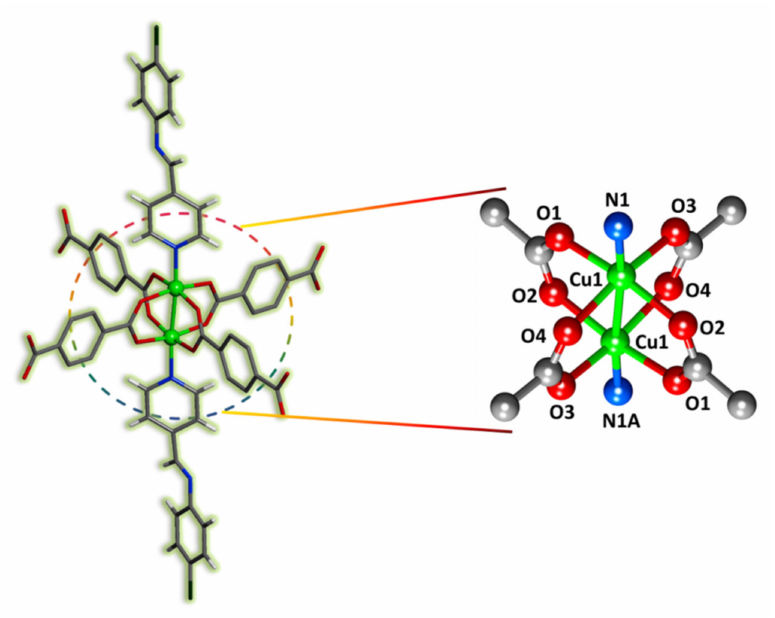
Figure 2. X-ray crystal structure illustrates the copper paddle-wheel secondary building unit in